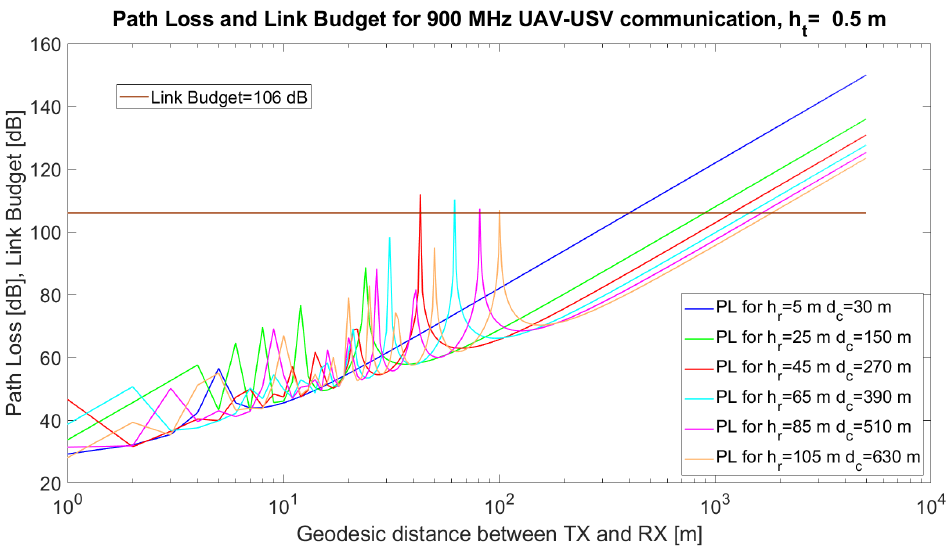
Figure 3. Path loss, link budget and critical distance for UAV–USV link, when USV antenna height is h t = 0.5 m and the solution in [57] is used.